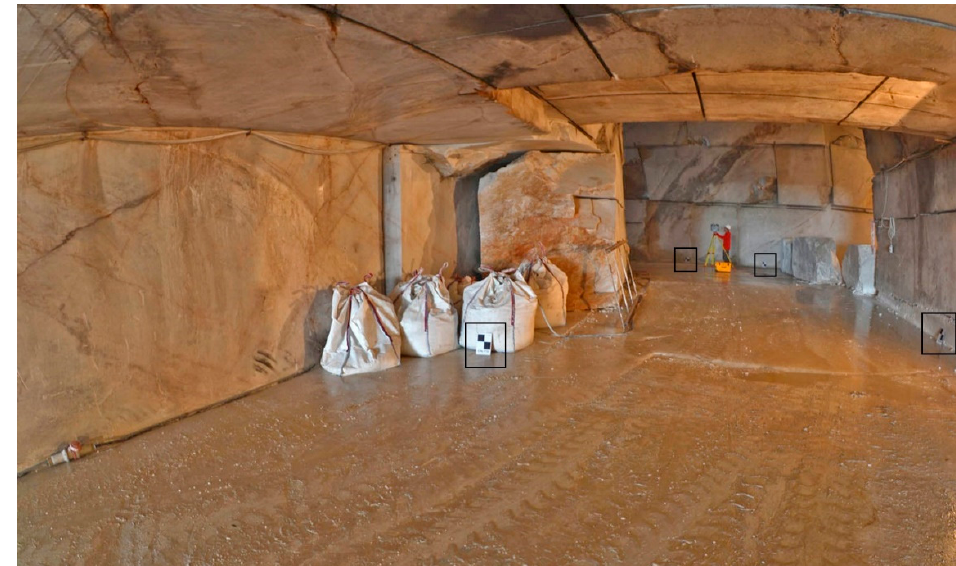
Figure 5. Operational phases of TLS. Example of black and white flat targets (highlighted with black rectangles) placed on the scene for TLS dataset georeferencing.